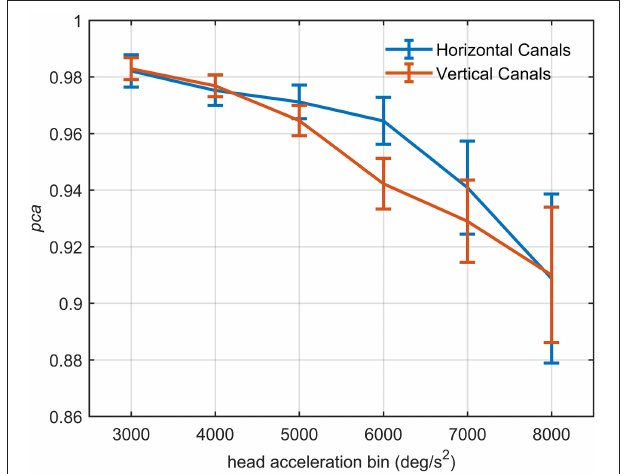
FIGURE 7 | Proportion of correct answers ( pca ) of the whole athlete group at different head acceleration bins. The error bars represent the pca and 95% confidence intervals estimated for bin of acceleration (3,000–8,000 deg/s 2 ) . Pca were computed using the single approach (Equation 1) for impulses performed in the plane of the horizontal (blue line) and vertical (red line) canals. Confidence intervals for pca were estimated as in Figure 3 . The relationship between head acceleration and test performance appeared different between the two tested vestibular canals. The vertical canals showed, indeed, a significant decrease of the pca already from the 5,000 deg/s 2 bin, while for the horizontal canal, the worsening in performance occur only after the 6,000 deg/s 2 bin ( Table 3